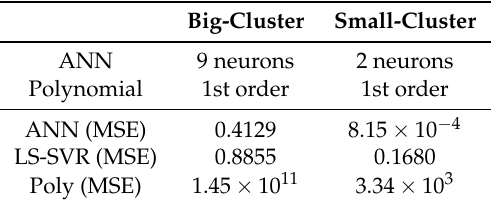
Table 4. Results of the chosen configuration. LS-SVR: Least Square Support Vector Regression.